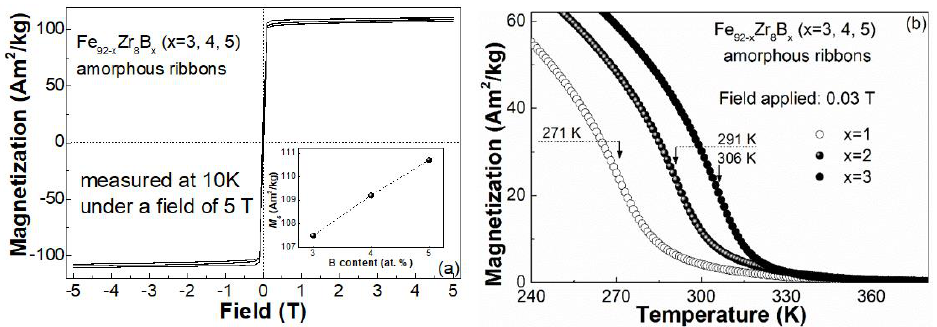
Figure 4. ( a ) Hysteresis loops of the Fe 92 − x Zr 8 B x (x = 3, 4, 5) amorphous ribbons measured at 10 K under a field of 5 T; the inset is the relationship between the M s and x. ( b ) The M - T curves of the Fe 92 − x Zr 8 B x (x = 3, 4, 5) amorphous alloys measured under a field of 0.03 T.